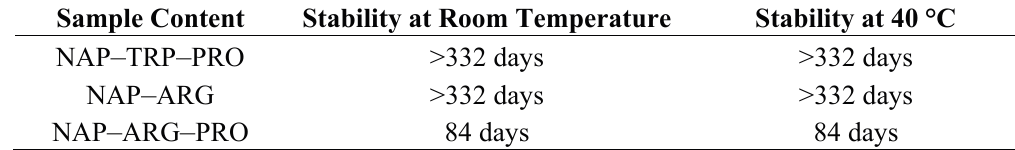
Table 3. Stability of co-amorphous NAP–TRP–PRO, NAP–ARG and NAP–ARG–PRO upon storage at room temperature and 40 °C under dry conditions.